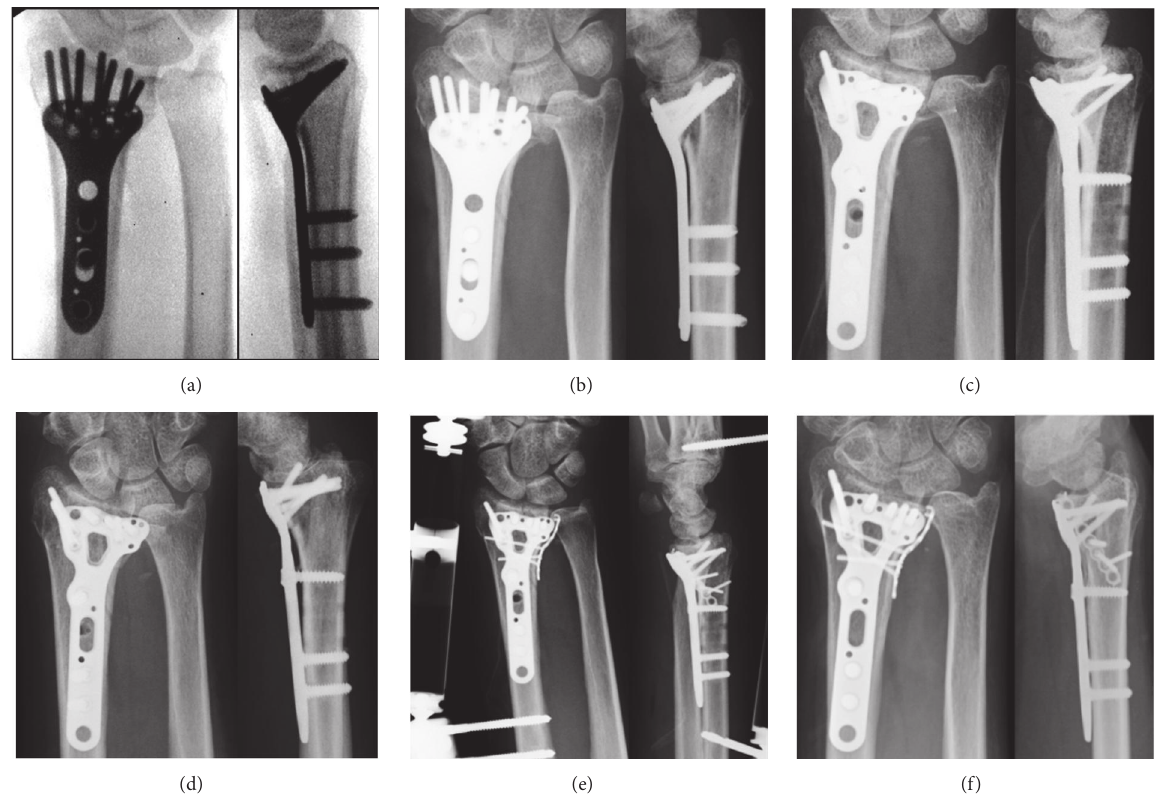
Figure 2: Plain radiographs of Patient 1. (a) Immediately after the first surgery. (b) Two weeks after the first surgery; redisplacement is seen. (c) Immediately after reoperation. (d) Five days after reoperation; redisplacement is seen. (e) Immediately after the third surgery. (f) One year after the third surgery; bone union was achieved without